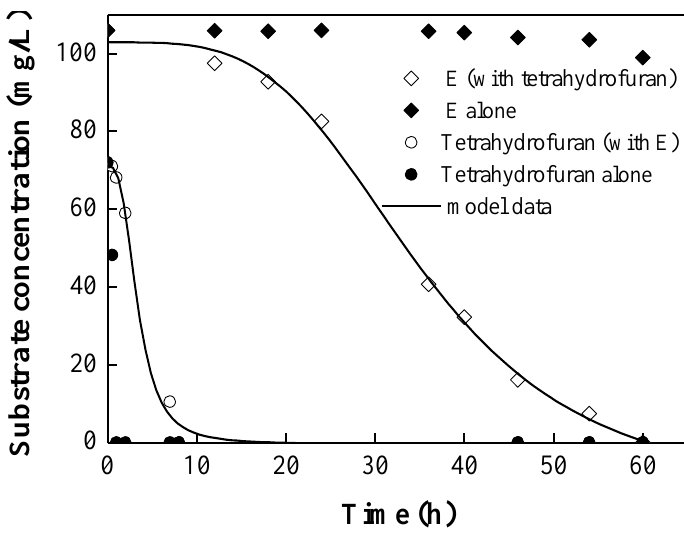
Figure 3. Dual degradation of tetrahydrofuran and E presented by experimental data (shapes) and sum kinetics with interaction parameter (SKIP) (lines). The initial culture density in each bottle was 20